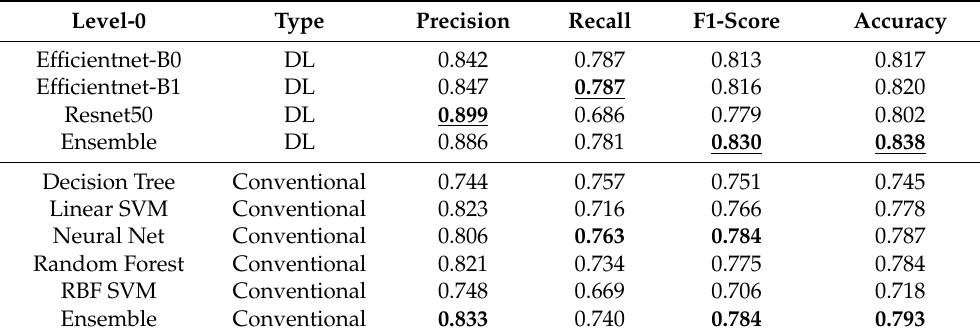
presented. The metrics were calculated after applying a threshold of 0.5 on the